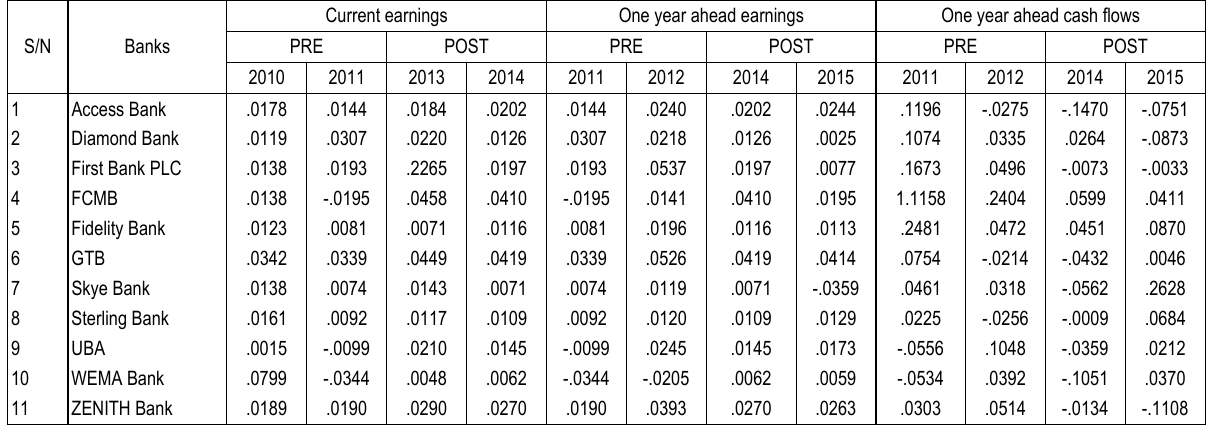
Table A2. Yearly measurement of variables of banks (earnings